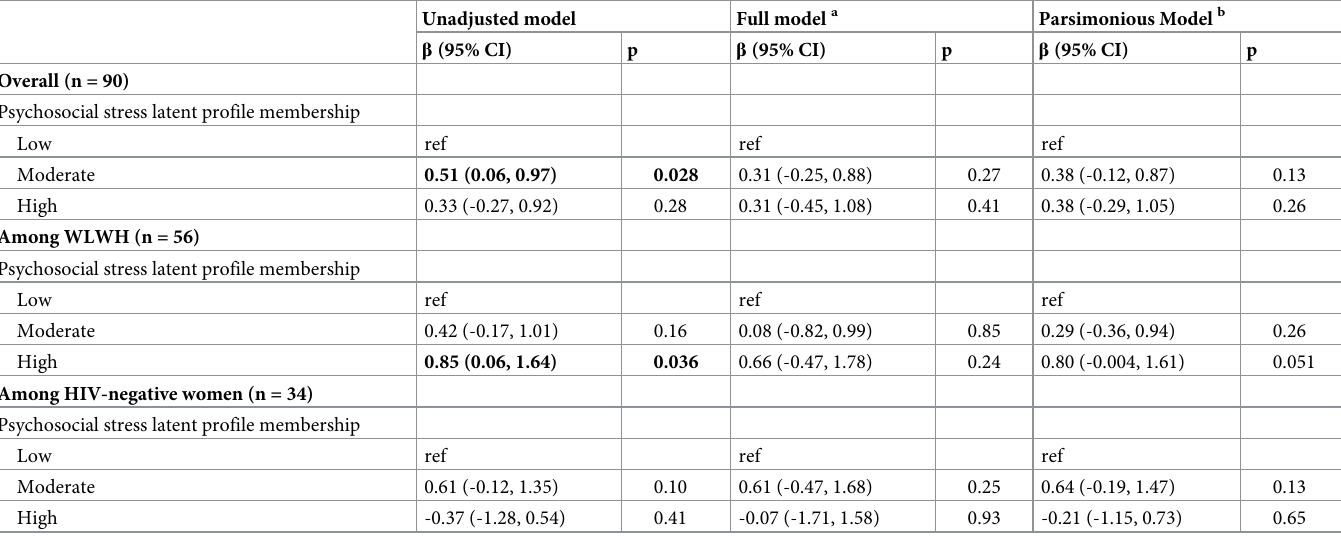
Table 5. Association between psychosocial stress and composite neuroendocrine biomarker index among all women and by HIV serostatus (n =